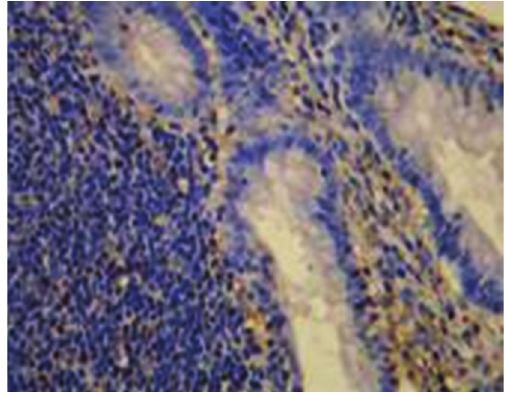
Figure 6: Model control group-28d mucous membrane of small intestine (++) NF- κ B × 200.